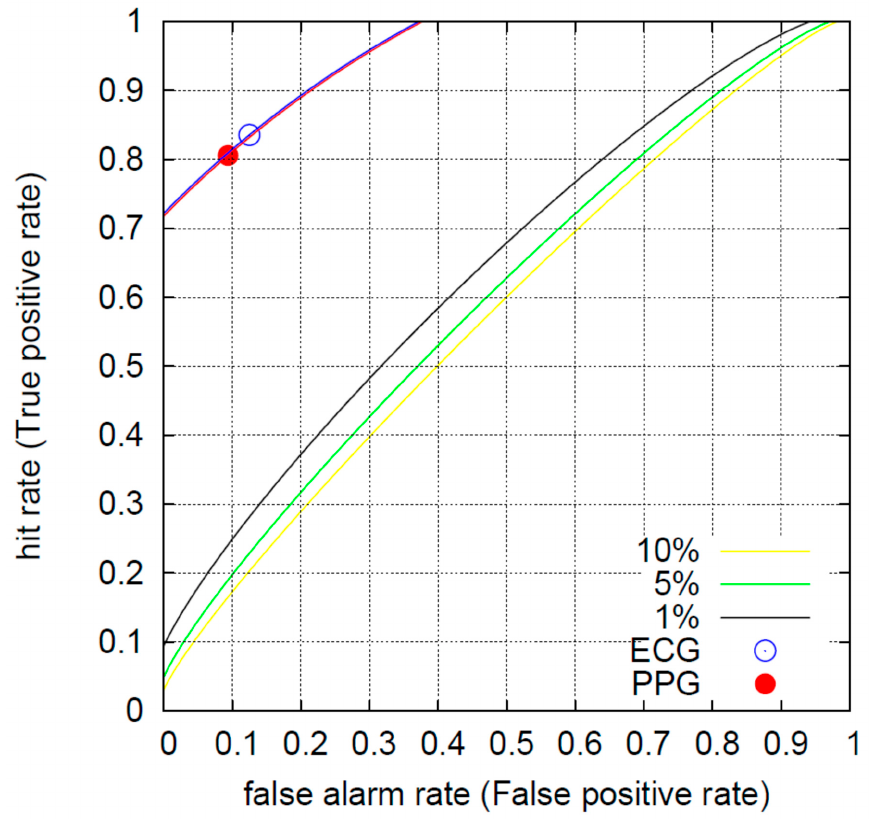
Figure 11. Receiver Operating Characteristics (ROC) diagram depicting the operating points when using PPG (red filled circle) or ECG (blue open circle) data according to the separation between CHF and H obtained by means of [ Λ 7] c and [ Λ 49] c in Figures 10 and 11, respectively, together with the corresponding ROC curves (red and blue, respectively) estimated on the basis of confidence ellipses [44]. The other three curves (yellow, green, black) correspond to the p ‐ values 10%, 5%, 1%, respectively, when 67 (= P) CHF individuals are to be selected out of 99 (= P + Q) cases [44]. The p ‐ values obtained for both PPG and ECG are well below 0.01% while the corresponding AUC are 0.953 and 0.954, respectively.